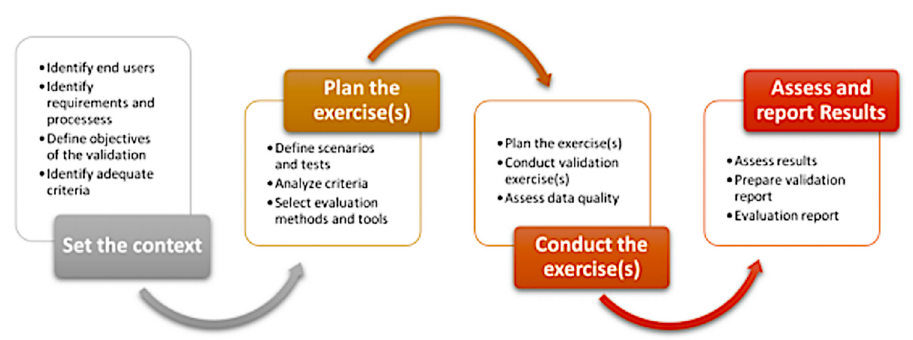
Figure 2. EU-CIRCLE case study implementation framework.